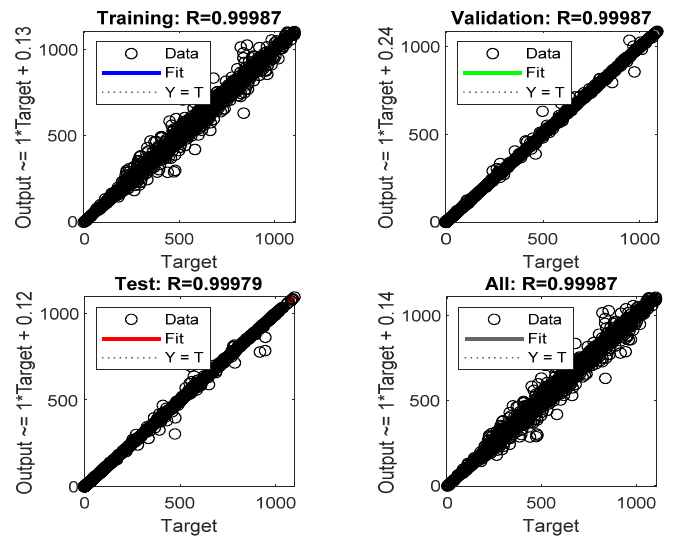
Figure 13. ANN regression.